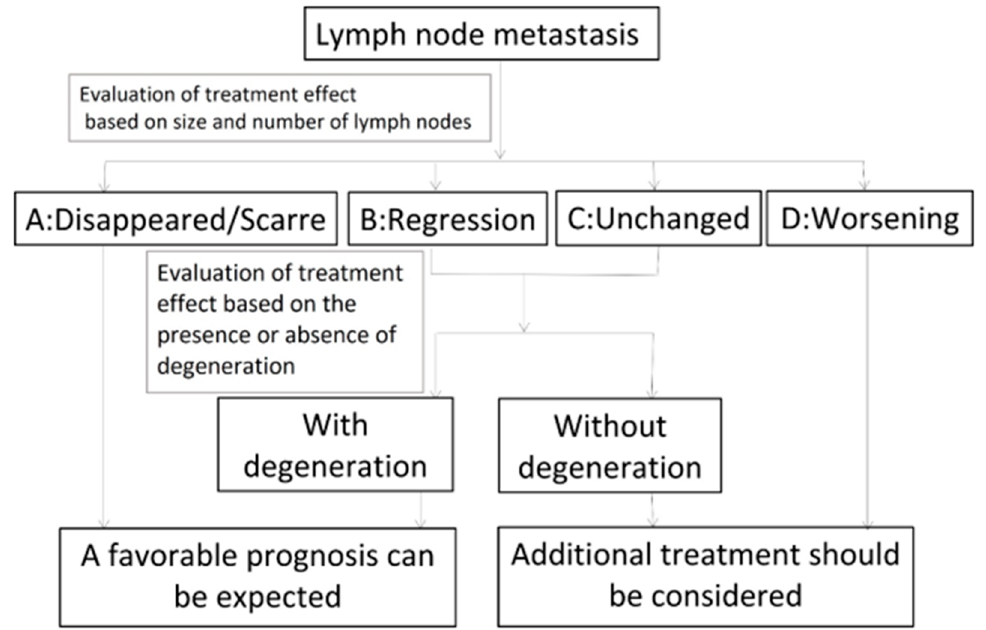
Figure 3. Evaluation of the effects of treatment on metastatic cervical lymph nodes using ultraso- nography.